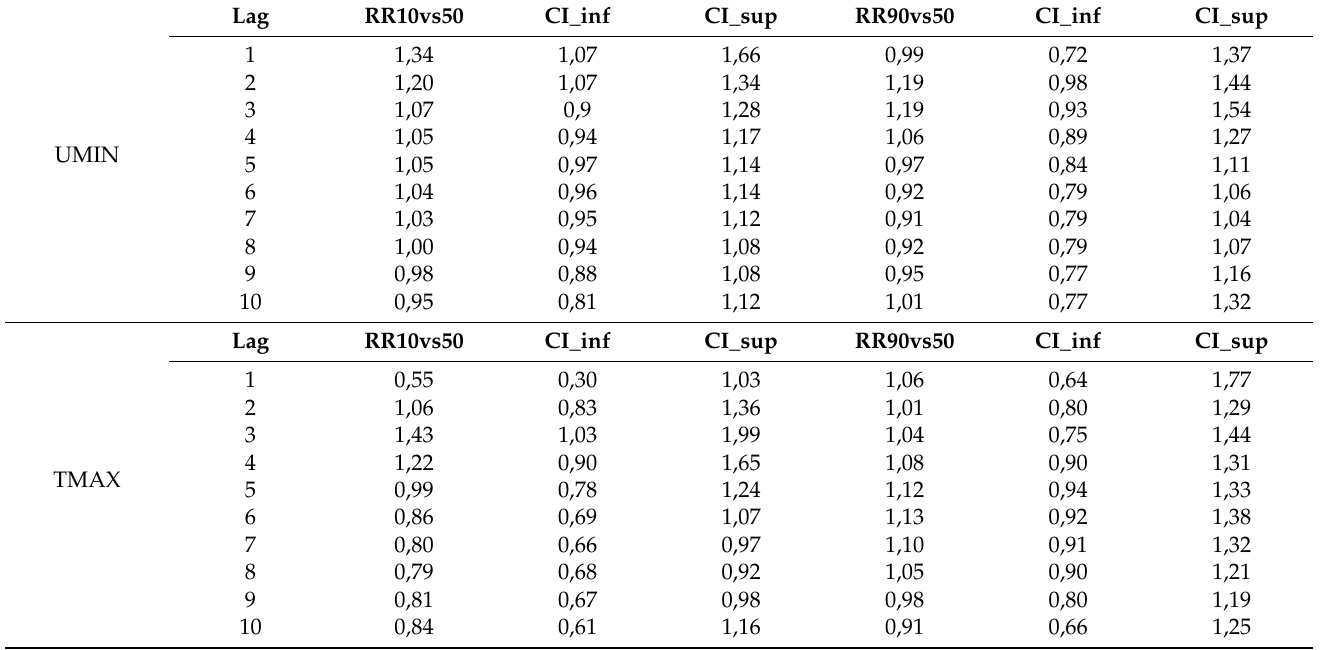
Table 2. Relative risk (RR) of hospital admission for low variable values (“RR10vs50”) and for high variable values (“RR90vs50”) with respect to average. A RR value greater than 1 indicates that the risk of hospitalization is increasing when moving towards lower (“RR10vs50“) or higher (“RR90vs50”) values with respect to the risk associated with average (i.e., median) values. UMIN: minimum